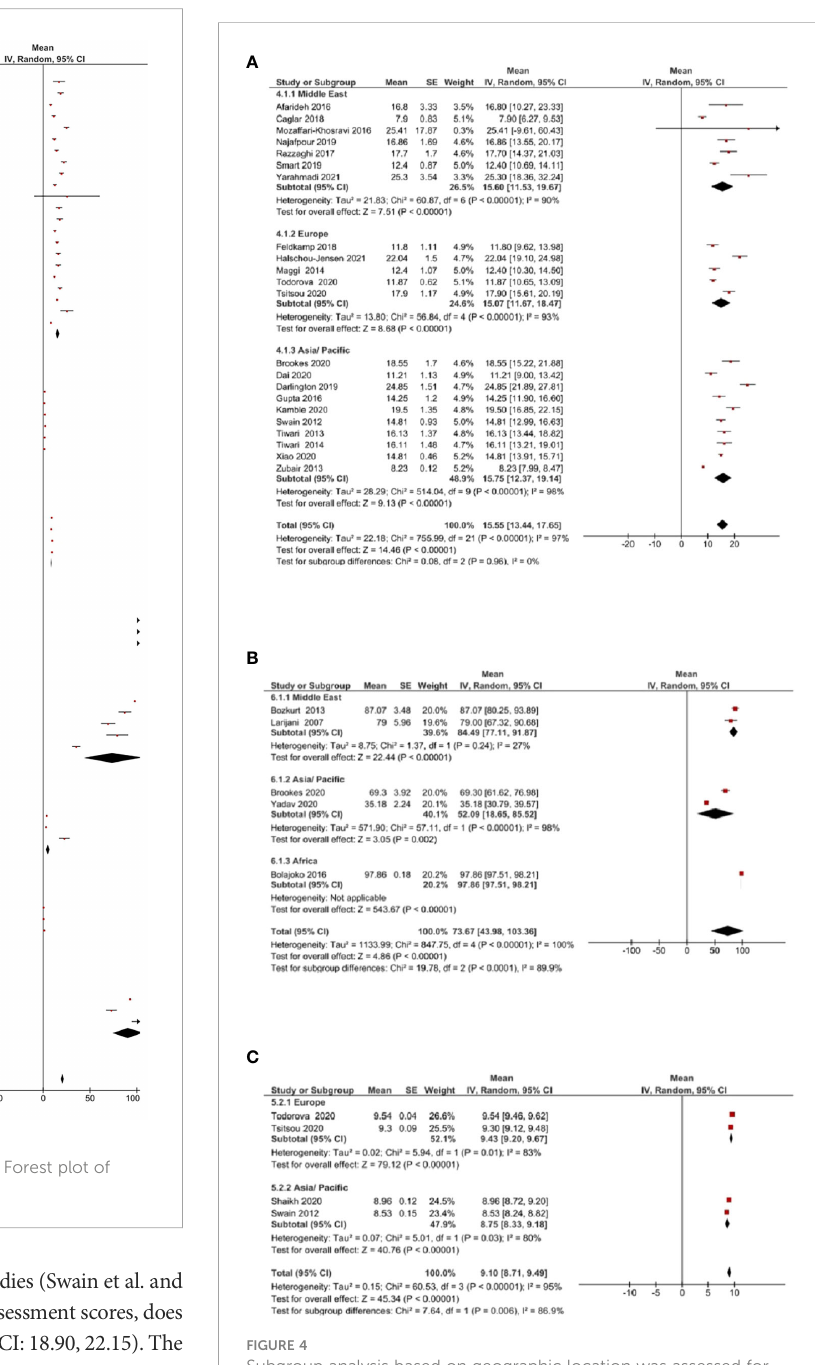
FIGURE 4 Subgroup analysis based on geographic location was assessed for vitamin D, zinc, and calcium. (A) Mean vitamin D levels across Middle East, Europe, and Asia/Paci fi c regions. (B) Mean zinc levels across Middle East, Asia/Paci fi c, and African regions. (C) Mean calcium levels across Europe and Asia/Paci fi c regions.